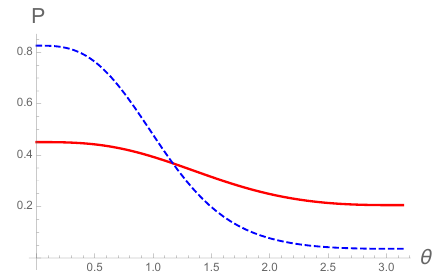
Fig. 1. Stationary probability distribution p st ( ✓ ), solution of equation (9) with @ t p = 0. It is a ⇡ -periodic distribution. The solid line is for 2 γ/ ⌦ = ˜ γ = 0 . 5, dashed line for ˜ γ = 2.